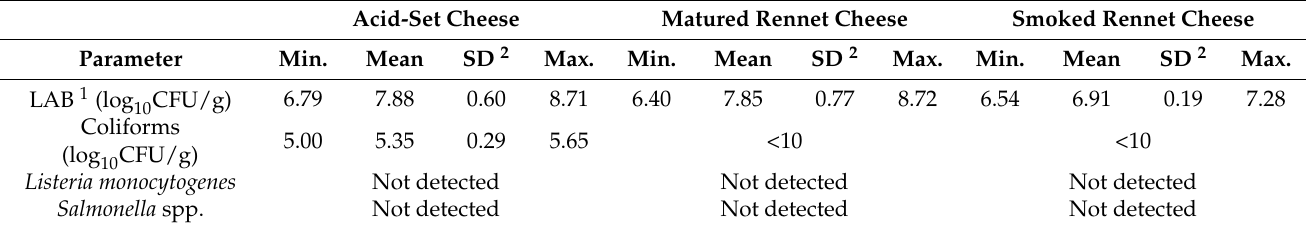
Table 1. Cow’s milk cheese microbiological